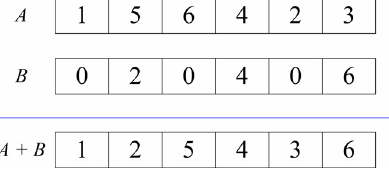
Fig. 8. Illustration of the redefined plus operator